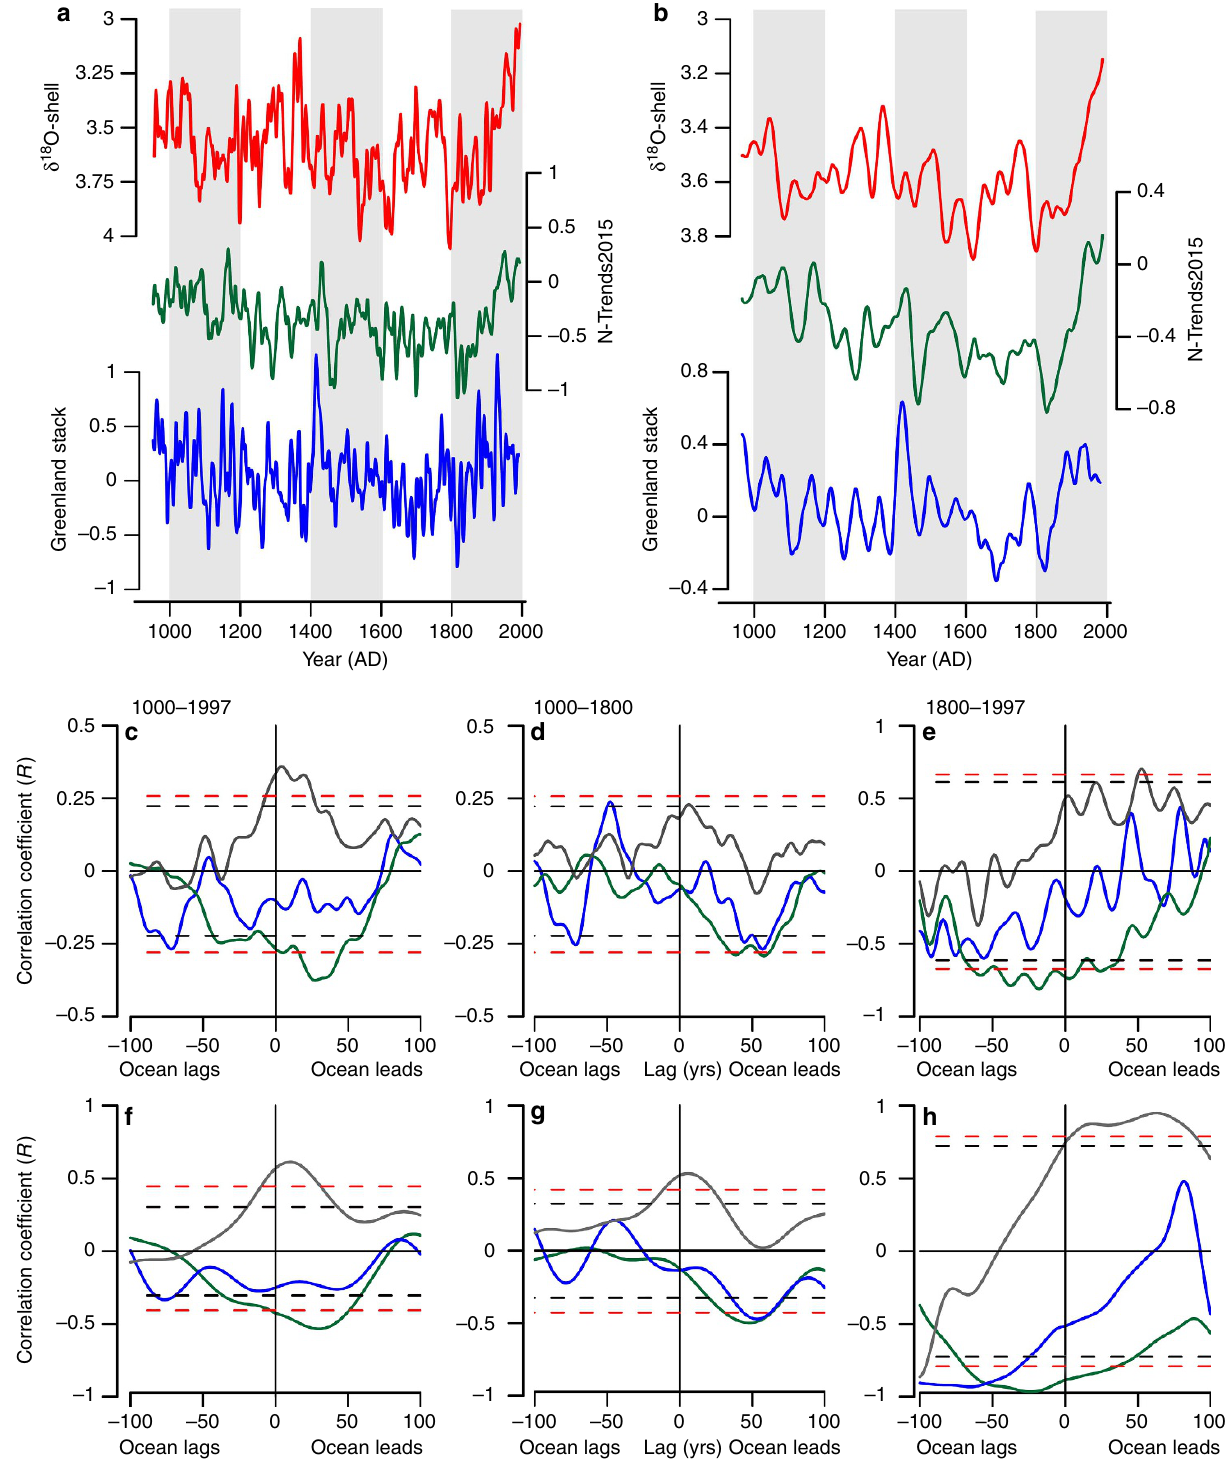
Figure 7 | Lead-lag correlation analysis between the inverted d 18 O-shell anomalies and NHSATs. NHSATs derived from a composite dendrochronological series 11 and Greenland air temperatures derived from a stack of Greenland ice cores 13 . ( a ) Ten-year and ( b ) 50-year loess first-order low-pass-filtered d 18 O- shell anomalies (red lines), Northern Hemisphere air temperatures (green lines) and Greenland air temperatures (blue lines). ( c – h ) Lead–lag correlation plots calculated between the d 18 O-shell series and Northern Hemisphere air temperatures (green lines), the d 18 O-shell series and Greenland air temperatures (blue lines), and Northern Hemisphere air temperatures and Greenland air temperatures (grey lines). The correlations are calculated over three periods. ( c , f ) Correlations calculated over the entire millennium. ( d , g ) Correlations calculated over the pre-industrial period (AD 1000–1800). ( e , h ) Correlations calculated over the industrial period (AD 1800–1997). Data used in the correlations in plots c – e were 10-year loess first-order low-pass filtered, whereas the data used to calculate the correlations in plots f – h were 50-year loess first-order low-pass filtered. The dashed black and red lines in plots ( c – h ) represent the respective 90 and 95% significance levels calculated using 1,000 Monte Carlo simulations using the Ebisuzaki method 37